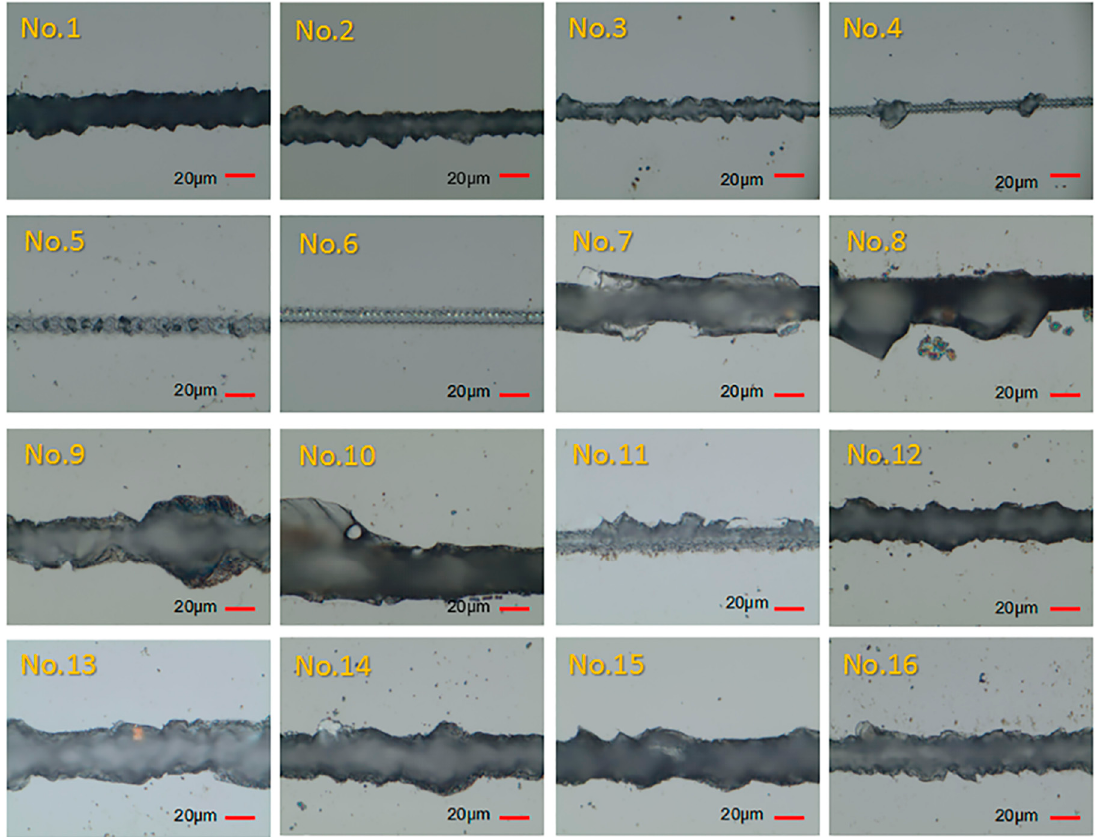
Figure 2. Top-surface images of laser-dicing samples under di ff erent parameters recorded with a digital microscope. The number located at each sample represents the experimental number in Table